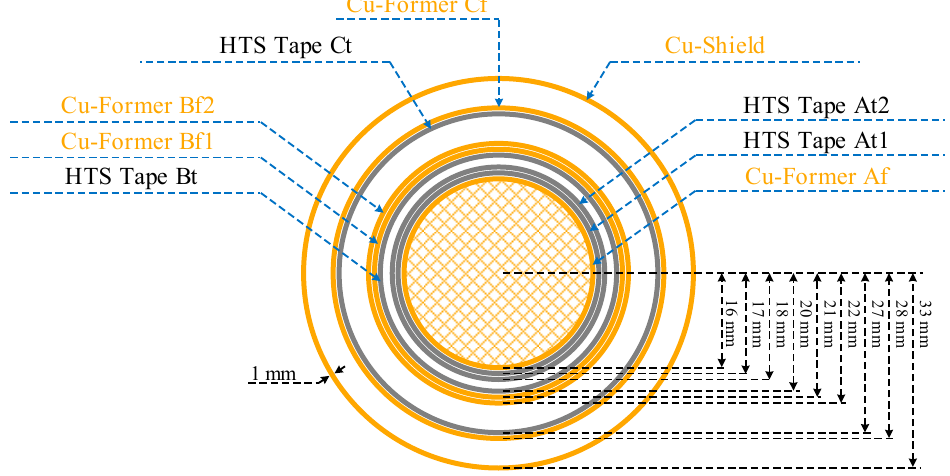
Figure 1. Configuration of the coaxial, multilayer high-temperature superconducting (HTS) power cable; phase A consists of two HTS layers and one Cu-former layer; phase B consists of two Cu-former layers and one HTS layer; and phase C consists of one HTS layer and one Cu-former layer. The shield layer is based on copper.